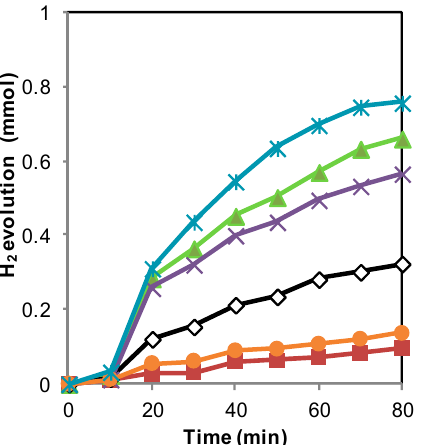
Figure 1. Photocatalytic H 2 production at 30 °C under ultraviolet (UV) irradiation over: TiO 2 ( ), CeO 2 ( ), TiO 2 ‐ 10%CeO 2 ( ), Au/TiO 2 ( ), Au/CeO 2 ( ) and Au/TiO 2 ‐ 10%CeO 2 ( ).